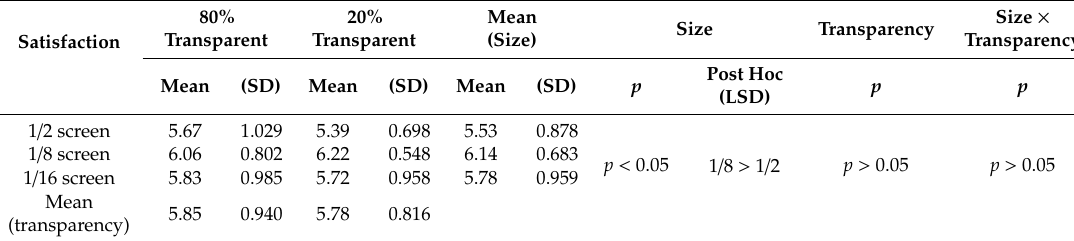
Table 6. Descriptive statistics and two-way ANOVA of satisfaction.